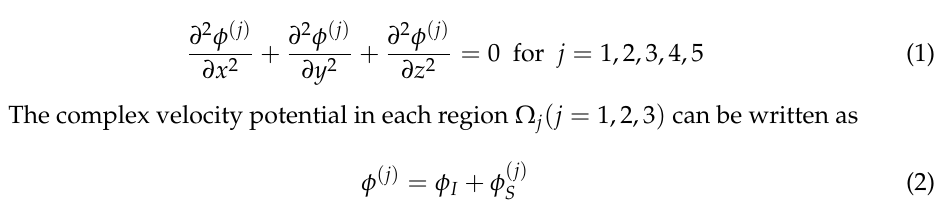
( j ) where φ I and φ denote the incident velocity potential and scattered velocity potential, S respectively, both of which satisfy Equation (1). For two incident waves propagating along the β and π − β directions, the total incident velocity potential φ I can be written as [21]: